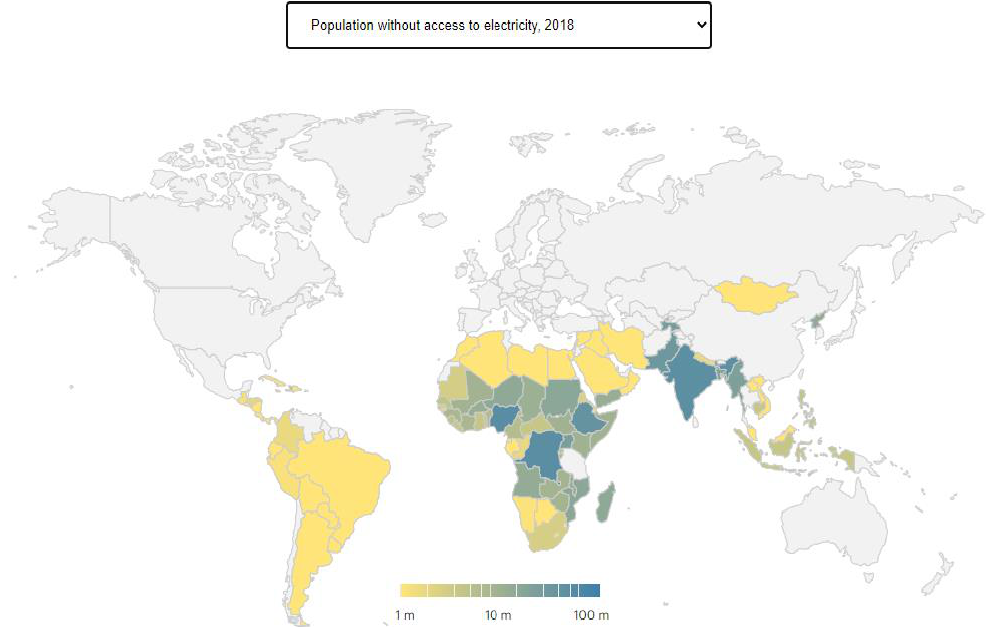
Figure 1. Population in the world without access to electricity (in millions) [49]. Source: IEA (2019) SDG7: Data and Projections. All rights reserved.